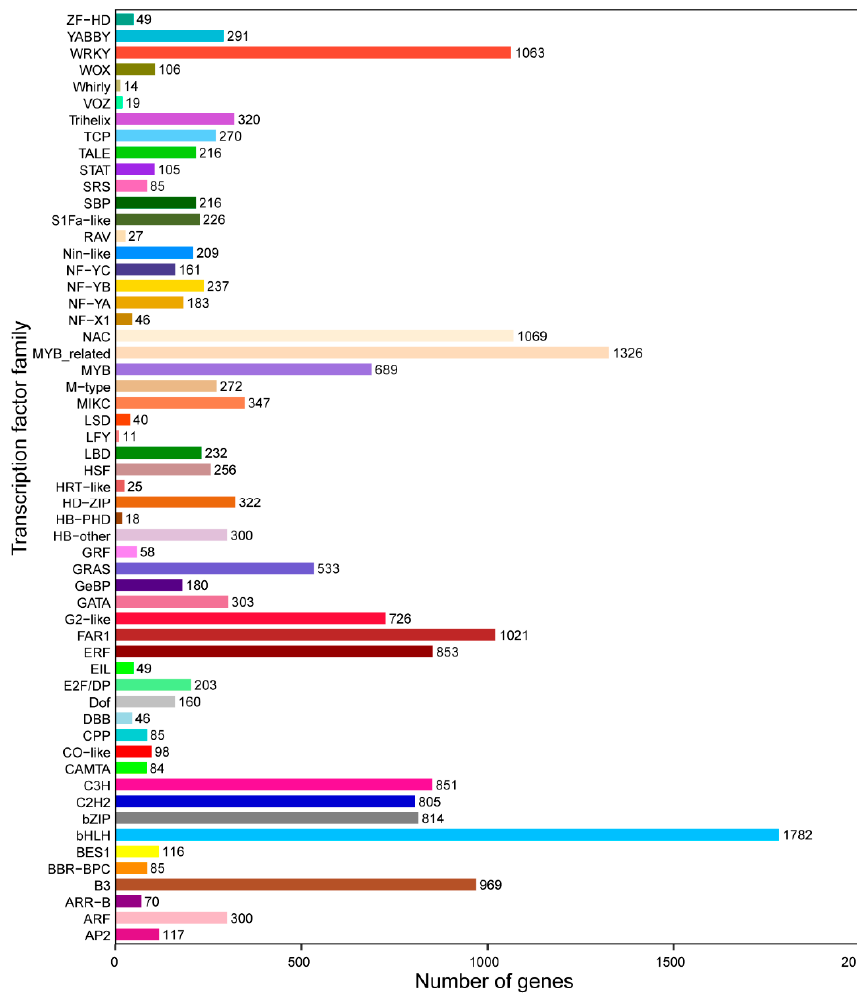
Figure 5. Distribution of transcription factor types in A. arguta cv. Qinziyu.